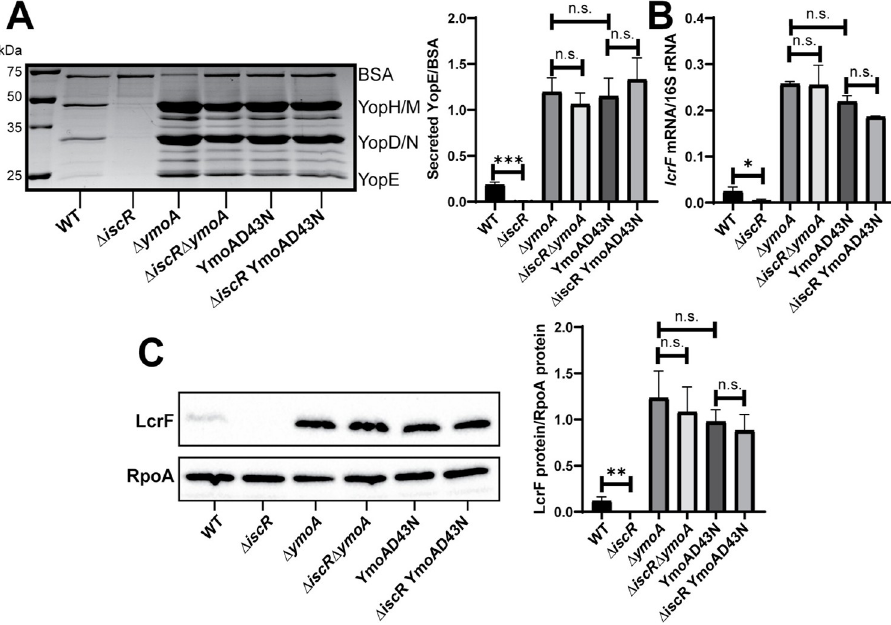
Fig 5. IscR is dispensable for type III secretion in the Δ ymoA mutant background. Yersinia strains were grown aerobically under T3SS-inducing conditions (low calcium at 37˚C). (A) Precipitated secreted proteins were visualized by SDS-PAGE followed by Coomassie blue staining. Bovine serum albumin (BSA) was used as a loading control (left panel). Densitometry was used to measure the relative amount of secreted YopE T3SS effector protein versus BSA control. The average of four independent replicates ± standard deviation is shown (right panel). (B) RNA was extracted and RT-qPCR was used to measure relative levels of lcrF mRNA normalized to 16S rRNA. The average of at least three biological replicates are shown ± standard deviation. (C) LcrF protein levels were determined by Western blotting (left panel) and densitometry (right panel) relative to the RpoA loading control. Shown is the average of four independent replicates ± standard deviation. Statistical analysis was performed using an unpaired Student’s t-test ( � p < .05, �� p < .01, ��� p < .001, and n.s.